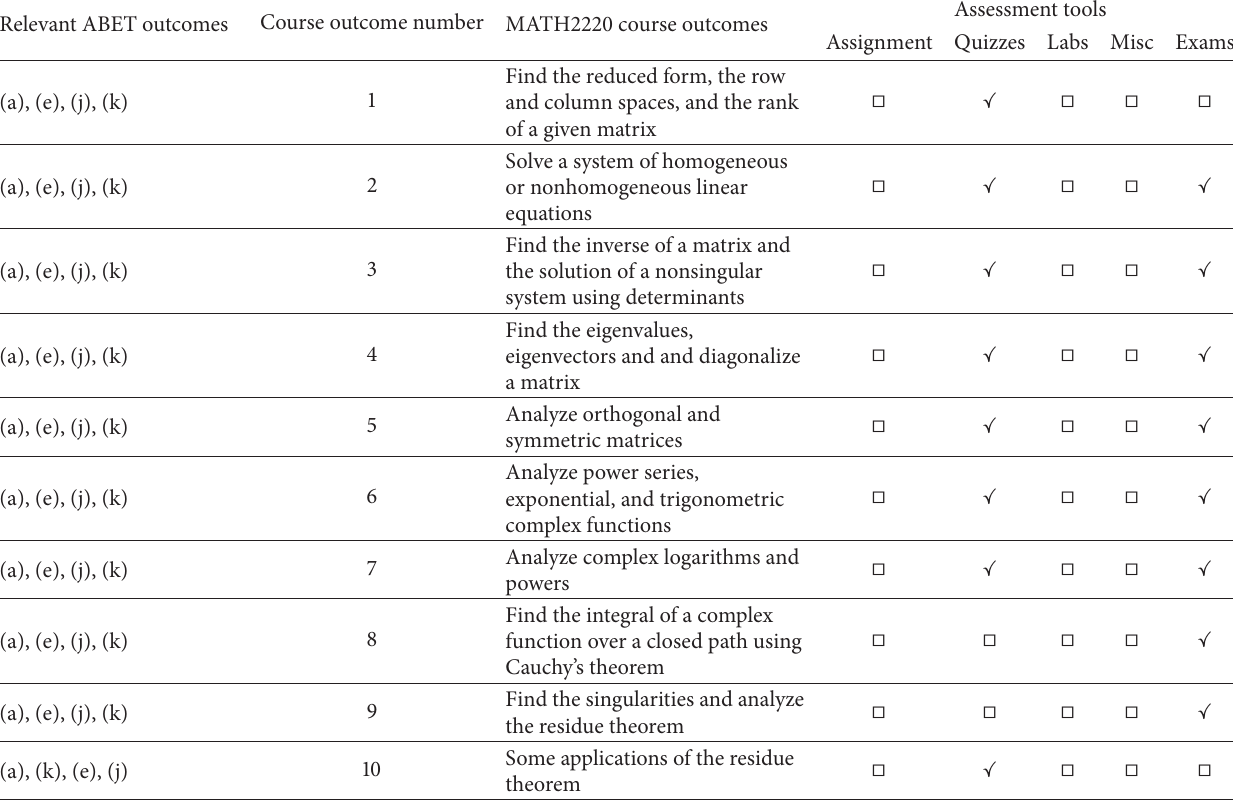
Table 4: Course outcomes, mapping with ABET and students direct assessment tools for the course MATH2220-linear algebra and engineering